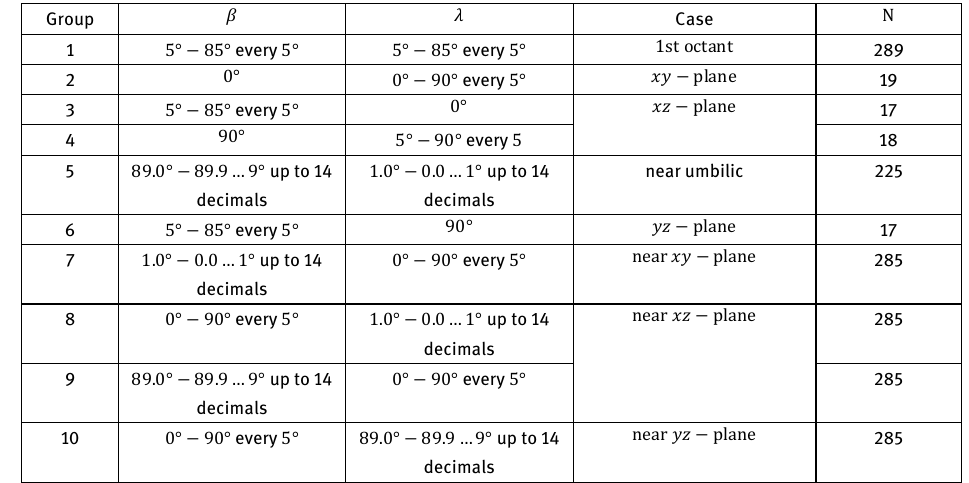
Table 1: Description of the points in the test set